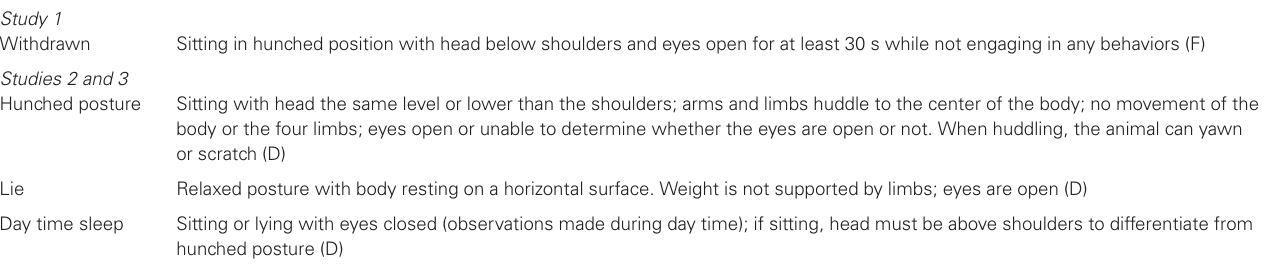
Table 1 | Definitions of behavior scored for adult rhesus males in the three studies